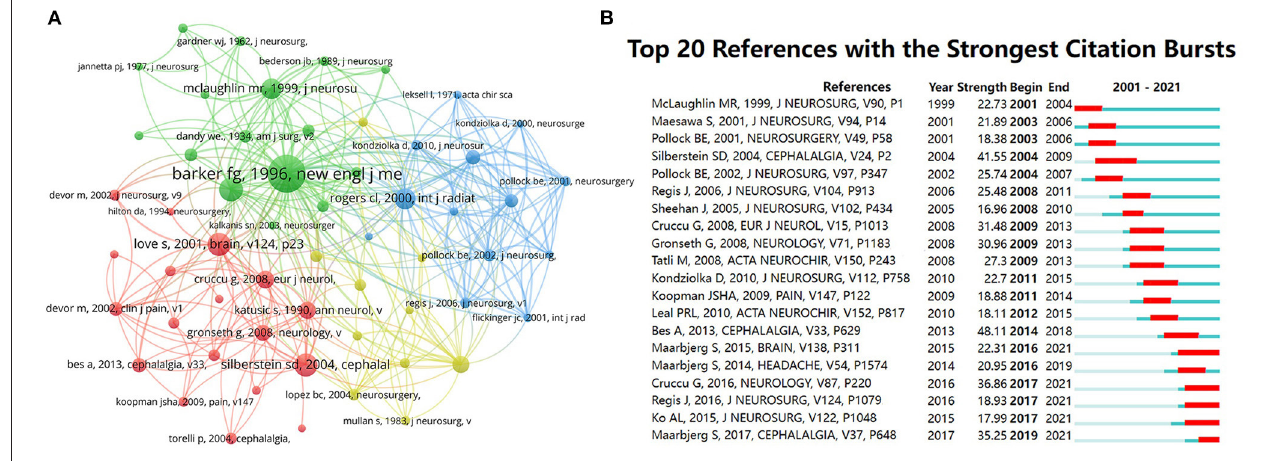
FIGURE 4 | (A) The co-citation network visualization map of references on TN research between 2001 and 2021. (B) The top 20 references with the strongest citation bursts on TN research from 2001 to 2021. The red segment of the blue line denoted the burst duration of a keyword.